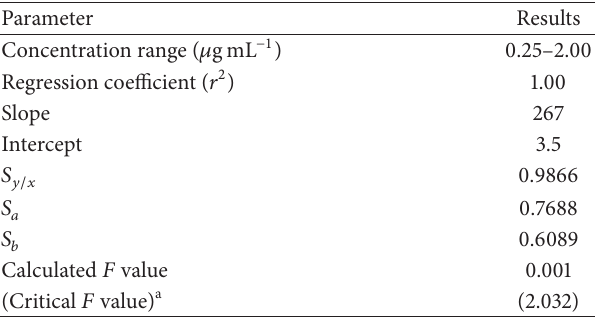
Figure 2: Effect of pH on fluorescence intensity. Table 1: Performance data for the proposed spectrofluorimetric method for determination of ganciclovir.